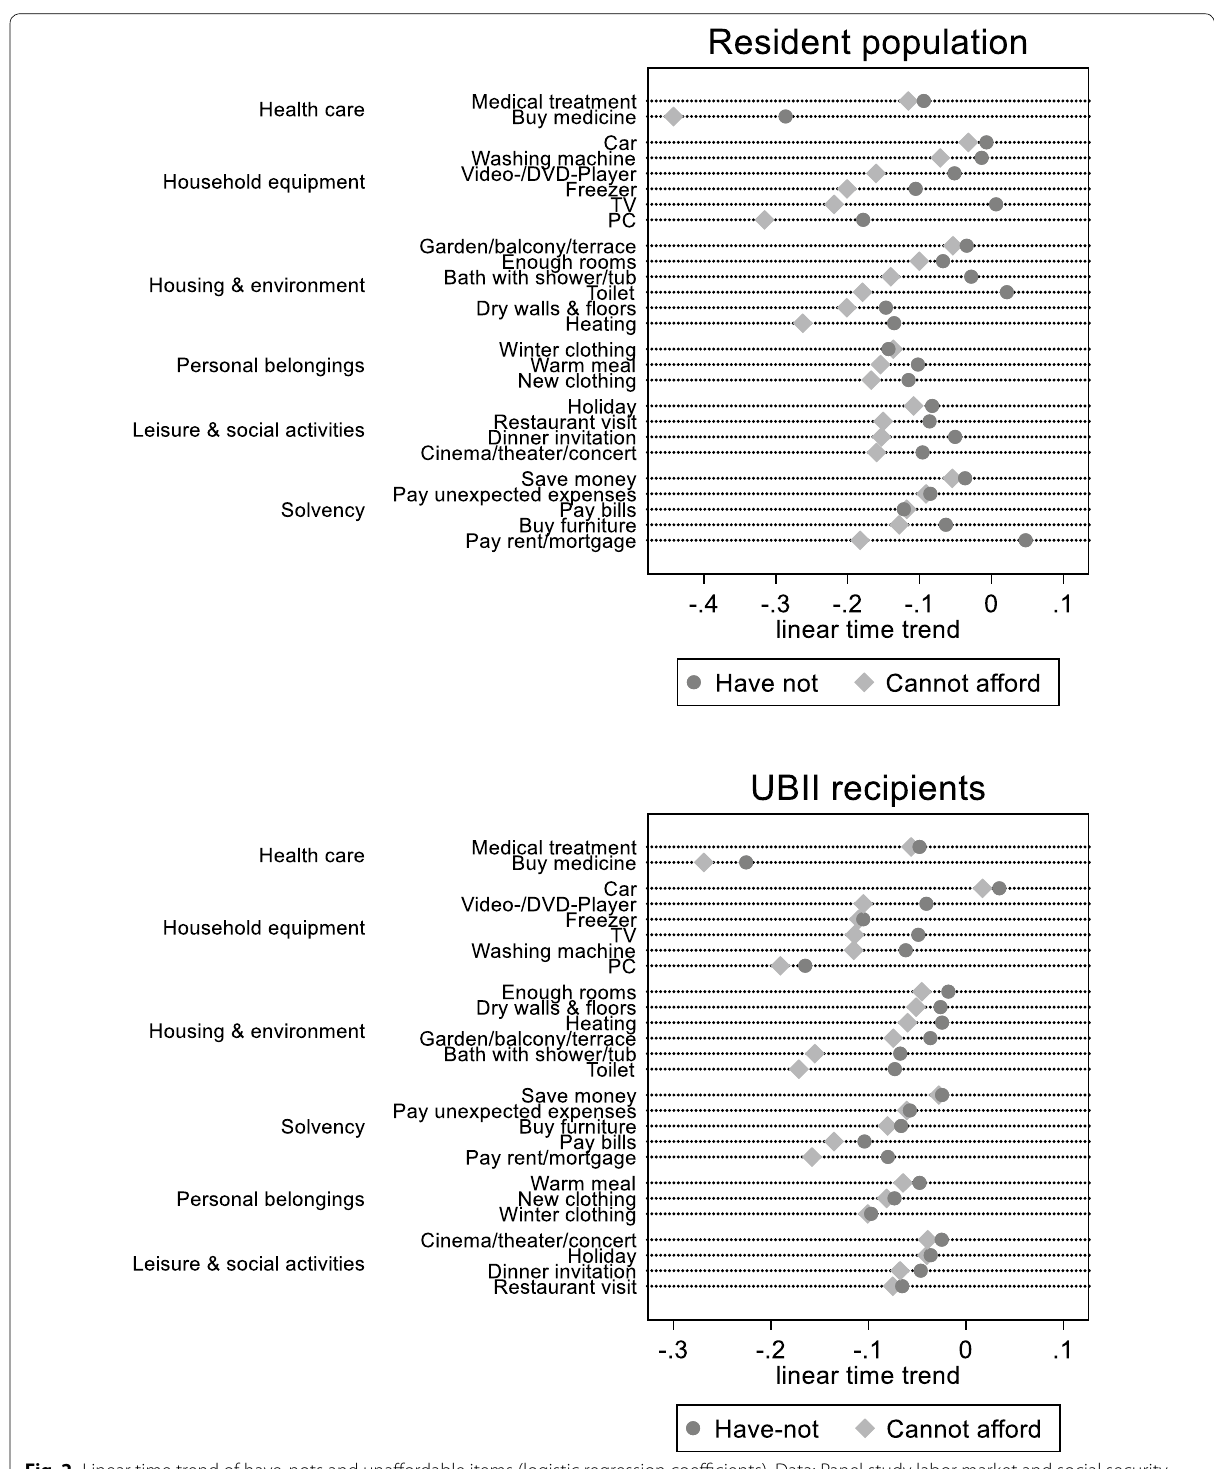
Fig. 2 Linear time trend of have‑nots and unaffordable items (logistic regression coefficients). Data: Panel study labor market and social security (PASS) samples 1, 2, 6, and 7; waves 1–7, 2006–2013. Logistic regression models controlling for survey design, selection probabilities,